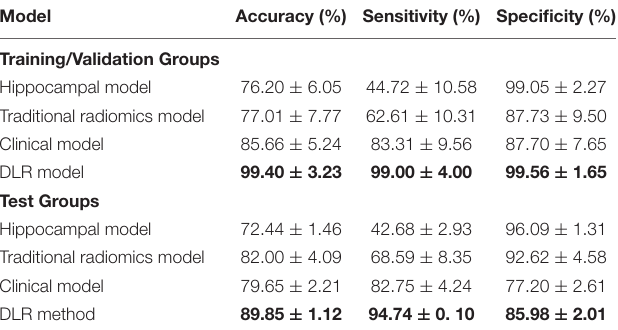
TABLE 3 | The classification results of preAD vs. NC.